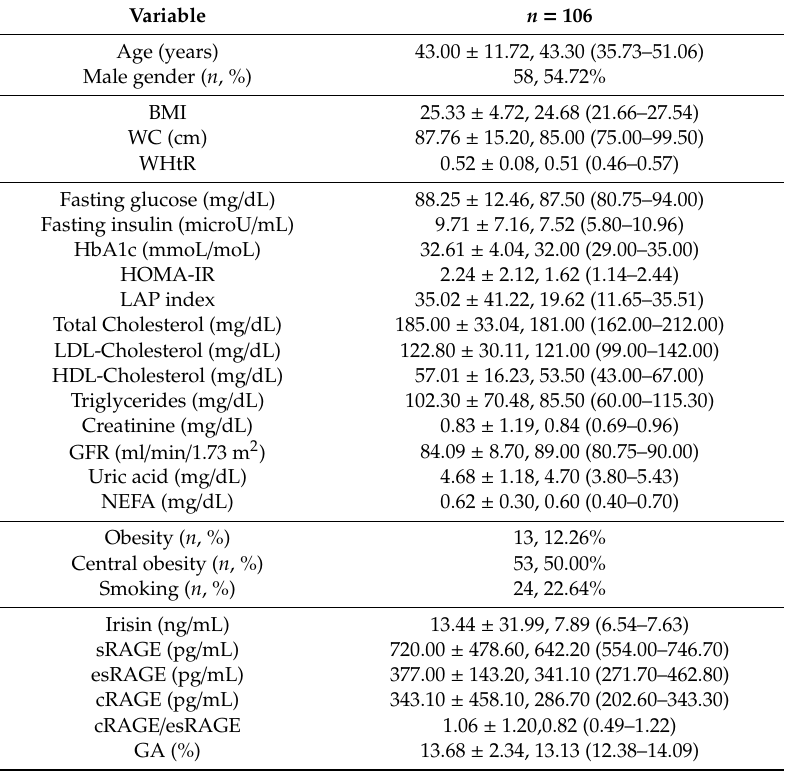
Table 1. Demographic, anthropometric, clinical and biochemical characteristics of individuals included in the